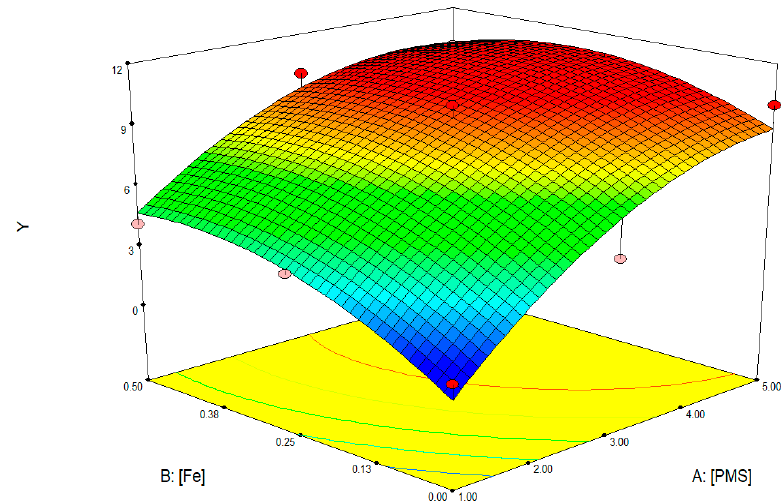
Figure 2. 3D response surface of FLP showing the reduction colonies (Y) at 15 min in function of the initial concentration of PMS (mM) and Fe +2 (mM).